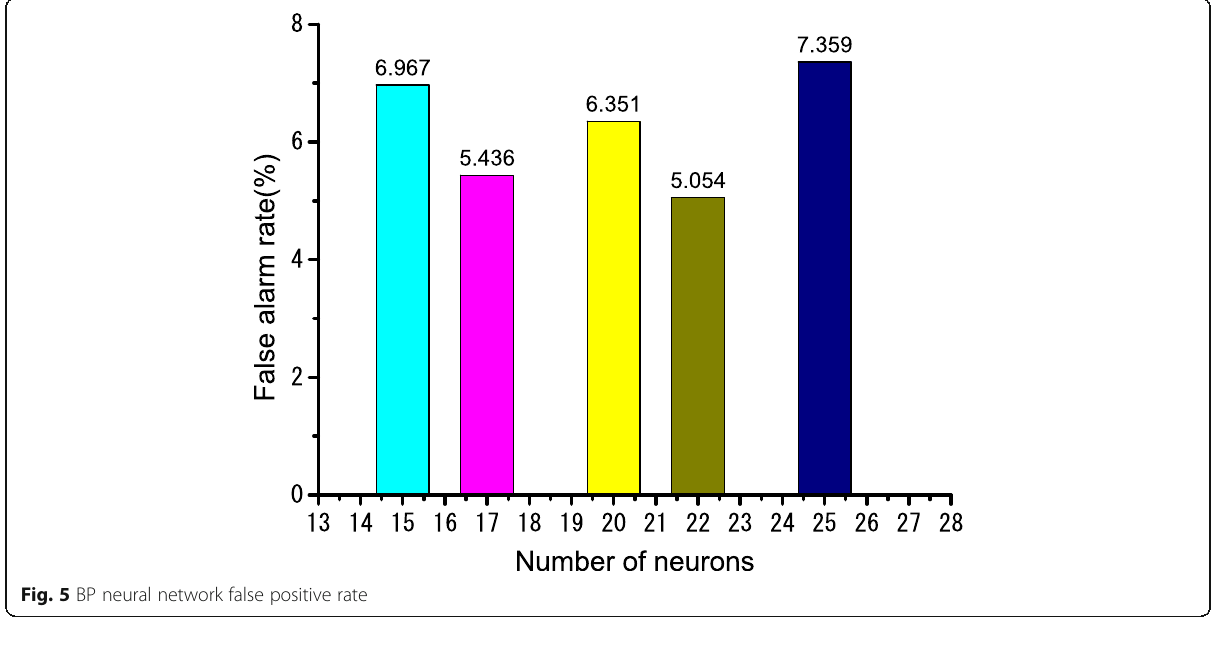
Fig. 5 BP neural network false positive rate